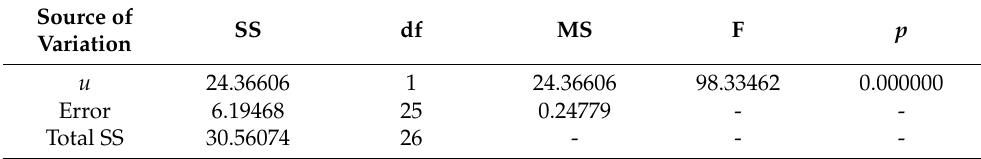
Table 9. Model of heat deflection temperature HDT—ANOVA table, R 2 = 0.80; R adj2 = 0.79. Source of Variation